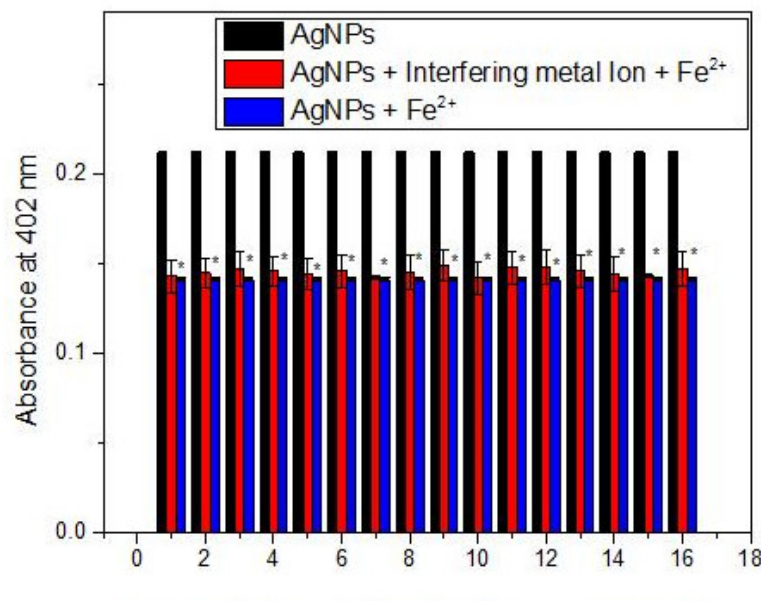
Figure 5. Interfering studies with different metals 1: Sb 3+ , 2: Pb 2+ , 3: Ca 2+ , 4: Fe 3+ , 5: Hg 2+ , 6: Co 2+ , 7: Ba 2+ , 8: Cu + , 9: Cd 2+ , 10: Ni 2+ , 11: Cu 2+ , 12: V 5+ , 13: Mg 2+ , 14: Mn 2+ , 15: Al 3+ , 16: Cr 3+ , * p < 0.01.